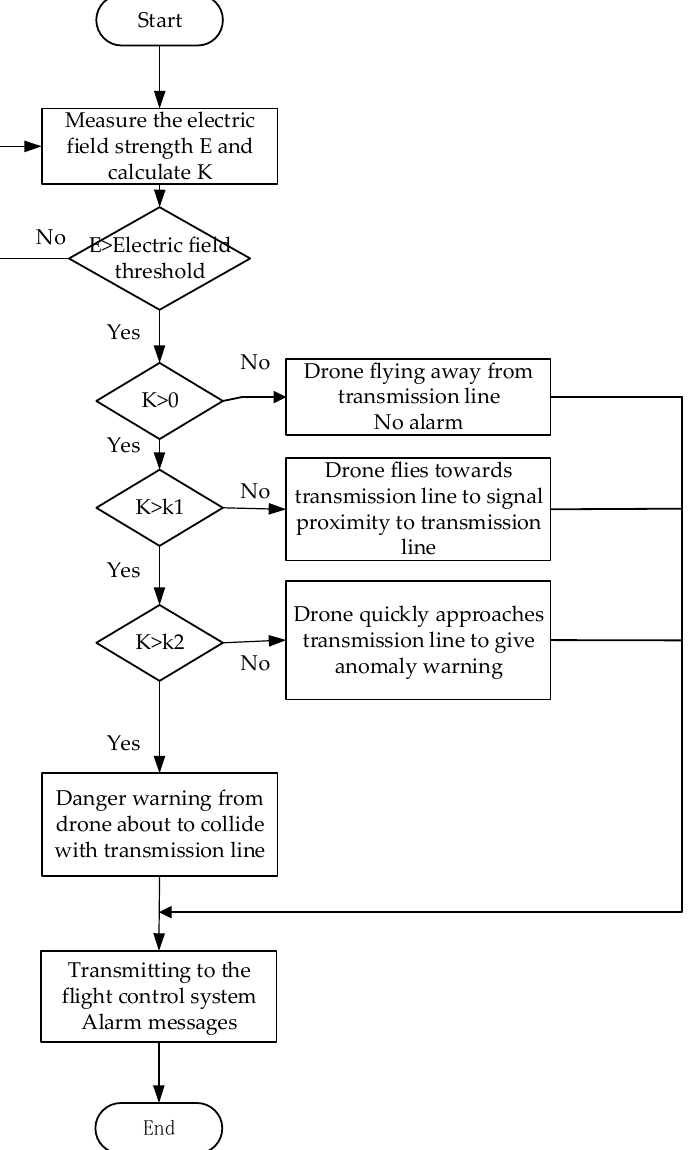
Figure 11. Flow chart of security early warning strategy.